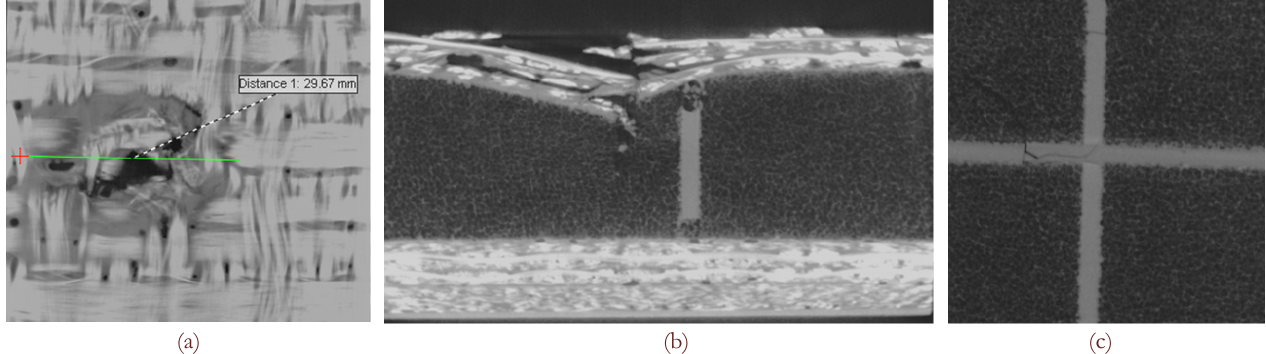
Figure 12: Tomographic images of the damaged GFRP-PVC foam core panel after the impact (v = 4 m/s).